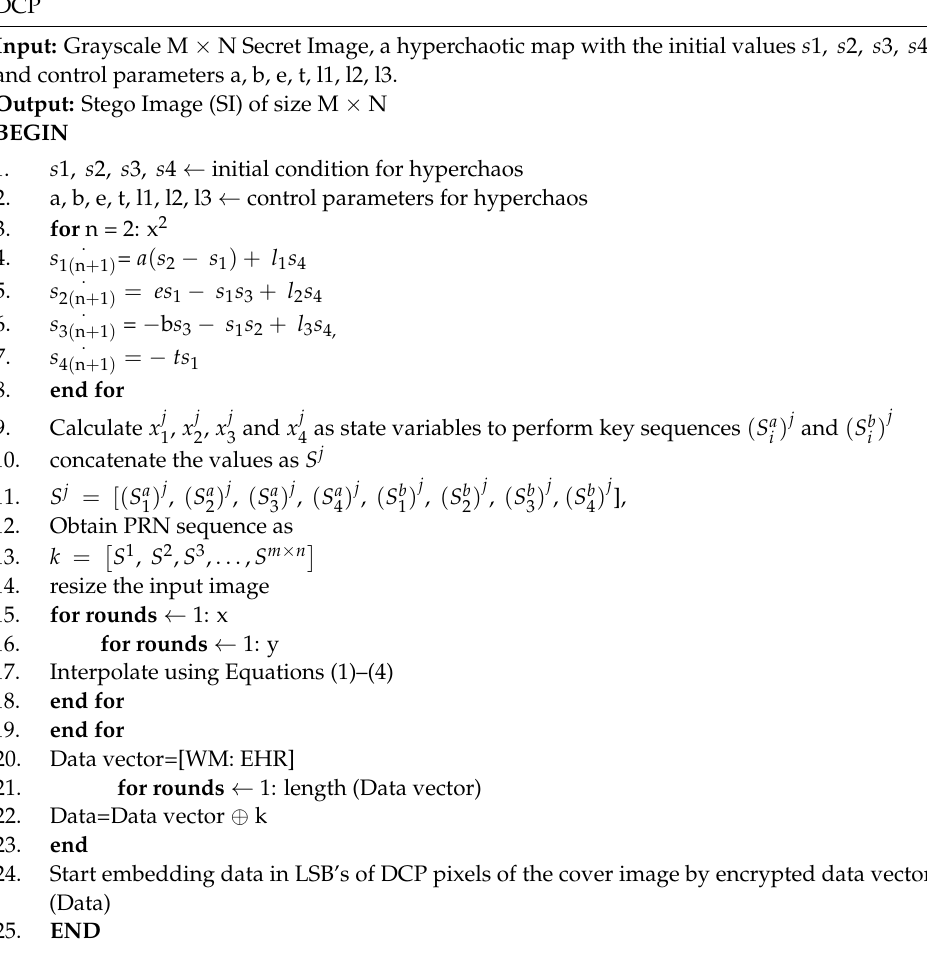
Algorithm 1. Image IP, EHR, and WM Encryption using HC, and LSB embedding of data bits